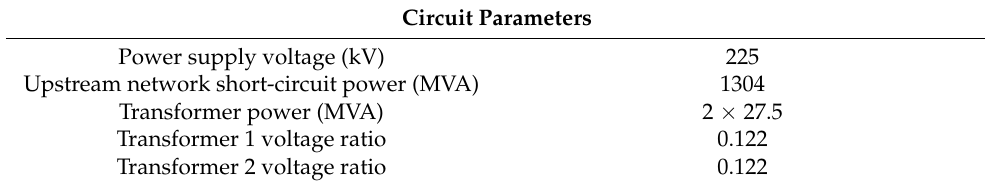
Table 1. “ Trois domaines ” substation characteristics.